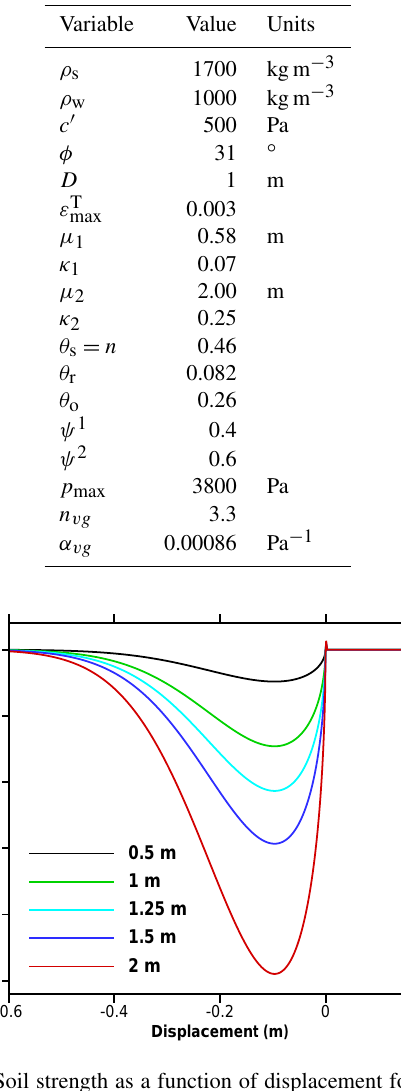
Table 2. Soil parameters used in all simulations.